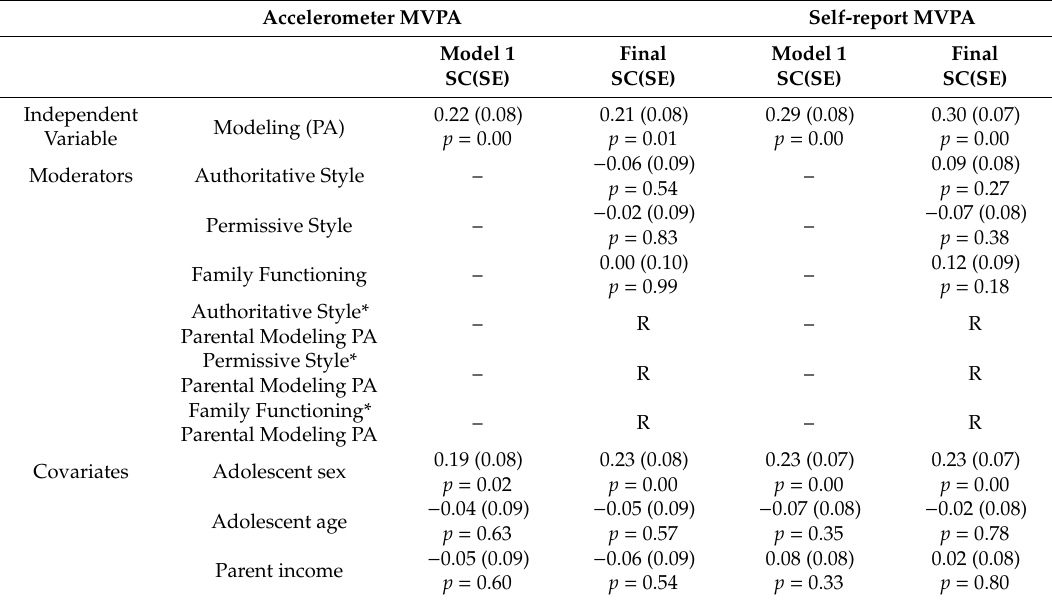
Table 5. Association between parental modeling of physical activity (PA) (accelerometer and self-report) and adolescents’ accelerometer and self-report of moderate-vigorous physical activity (MVPA).